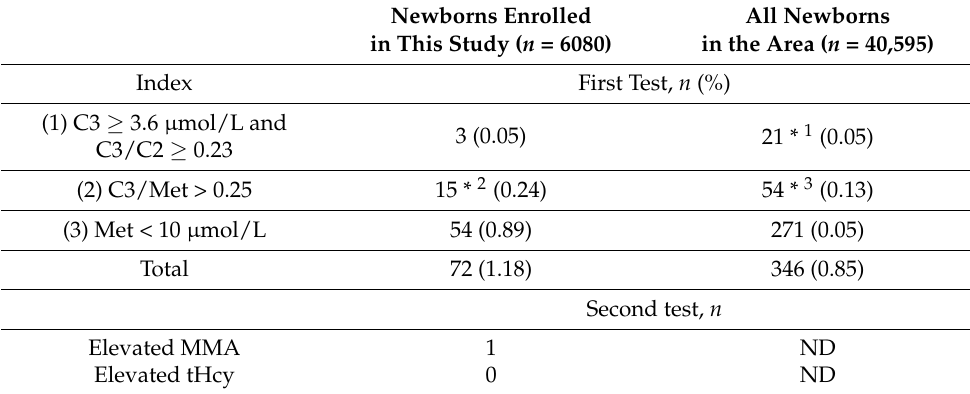
Table 4. Prospective pilot screening in the Hiroshima area from April 2019 to March